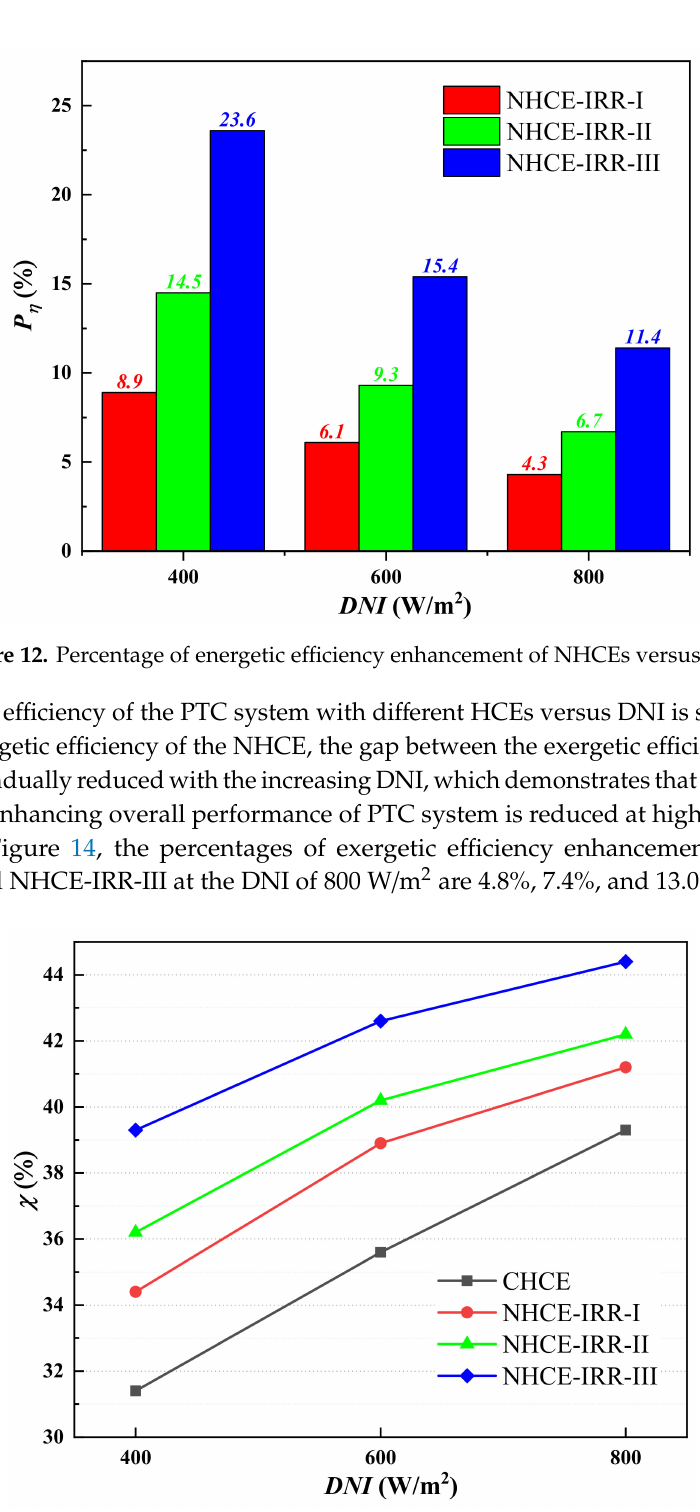
Figure 13. Exergetic e ffi ciency of PTC system with di ff erent HCEs versus